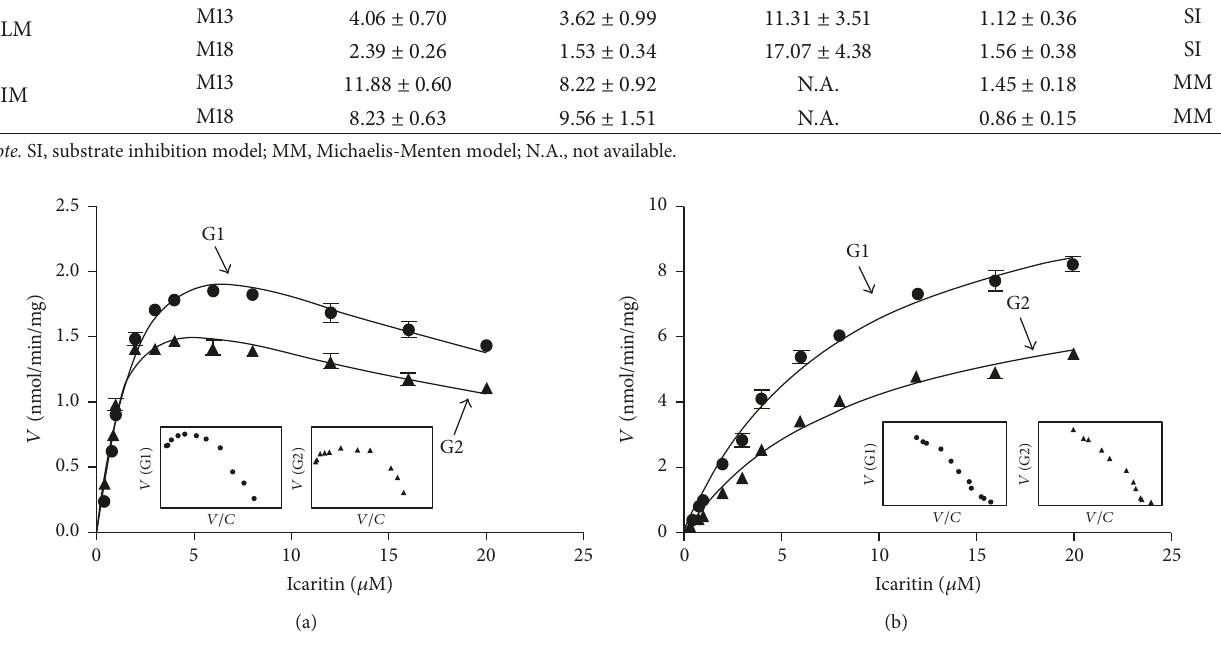
tract [31]. Massive metabolites containing M6, M8, M13, M17, M25,